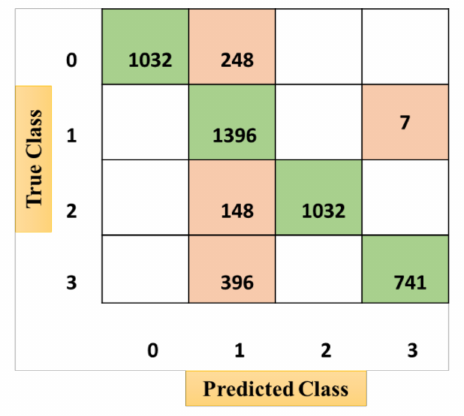
Figure 11. Confusion matrix for the support vector machine.